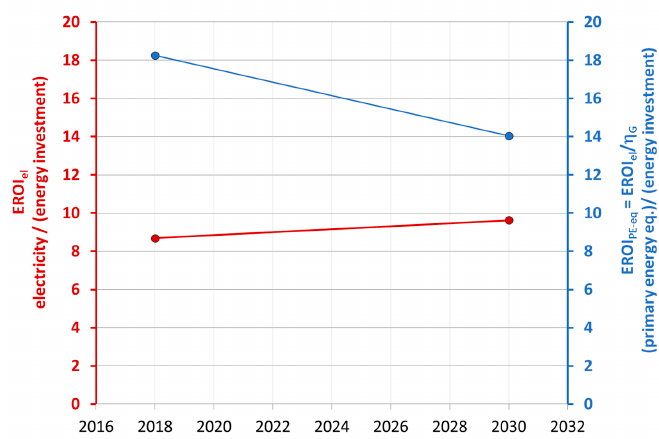
Figure 11. Energy return on (energy) investment (EROI el and EROI PE-eq ) of the California domestic grid mix. Specifically, changes in η G are at the root of the differences in EROI PE ‐ eq results for PV in California vs. those previously reported by the same authors when considering a more generalised thermal grid mix ( η G = 0.30) [50]. Table 2. EROI el and EROI PE ‐ eq values for individual electricity generation technologies in California, in the years 2018 and 2030.